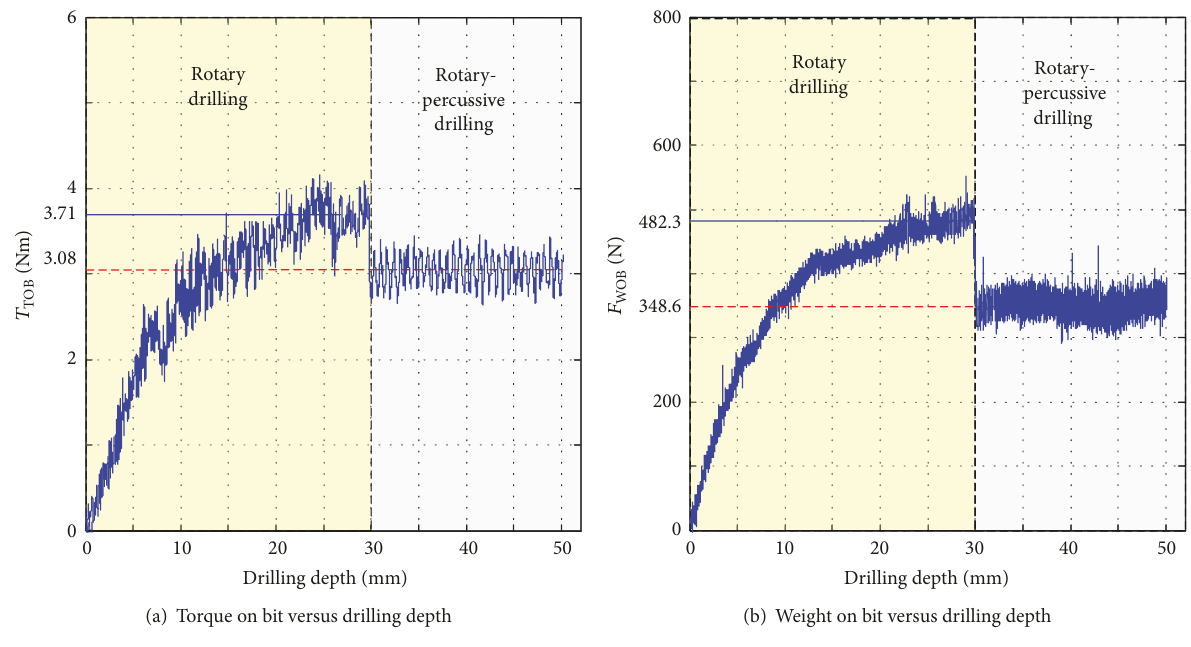
Figure 12: Comparison of the LRCB drilling load before and after percussion applied.